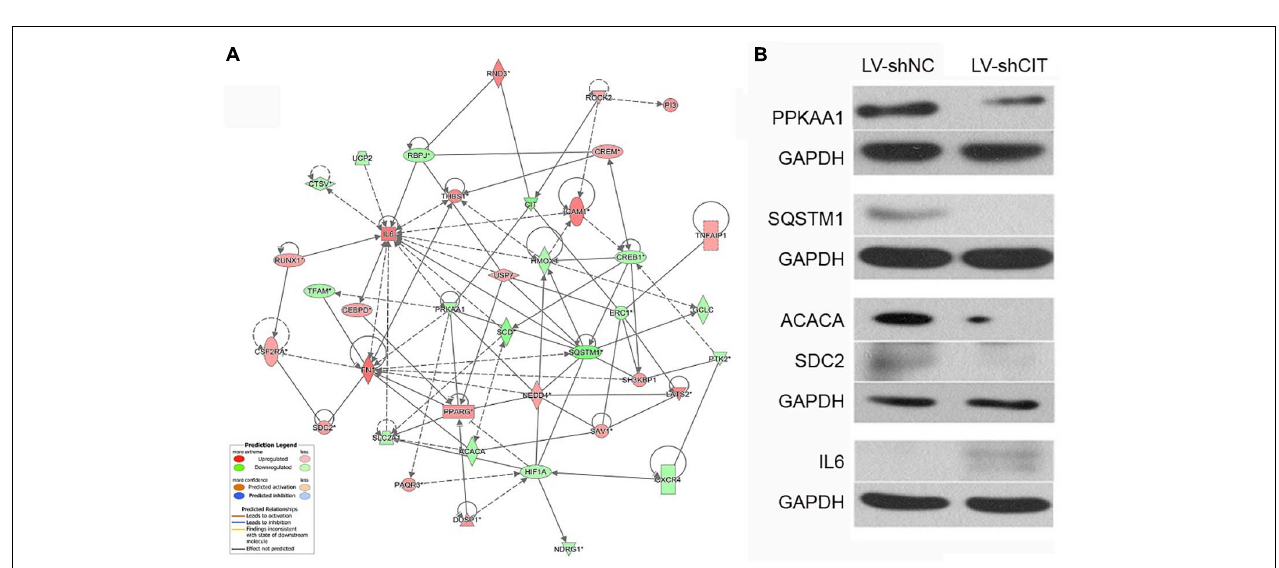
FIGURE 4 | Heatmap and enrichment analysis of differentially expressed genes (DEGs). (A) Heatmap showing DEGs from all samples. Red indicates that gene expression was relatively upregulated, green indicates downregulation, black suggests no change, and gray suggests that gene signal value was not detected. (B) Enrichment analysis of DEGs in classical signaling pathways. All pathways were ranked by –Log (P-value). Orange represents Z-score > 0, and blue represents Z-score < 0. Z-score > 2 represents pathways that were significantly activated, and Z-score < − 2 represents pathways that were significantly suppressed. Ratio indicates the ratio of the number of DEGs to all genes in the signaling pathway. (C) Enrichment analysis of DEGs in the classification of diseases and functions. All diseases and functions were ranked by –Log (P-value).